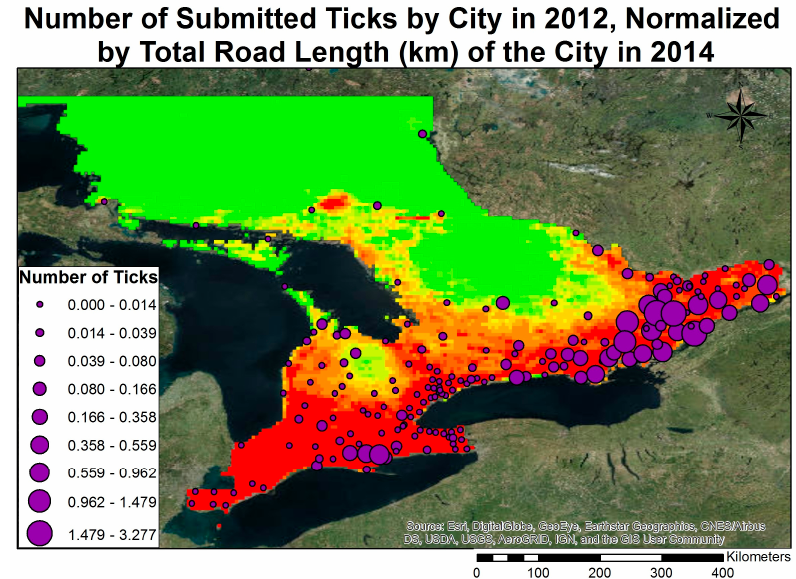
Figure 4. The number of ticks submitted to Public Health Ontario (normalized according to road length to account for population accessibility differences) and plotted over the tick suitability output by the model. Red represents always sustainable, green regions became sustainable during the study period, and black areas are consistently unsustainable. The number of ticks was multiplied by a factor of 100 for clarity.